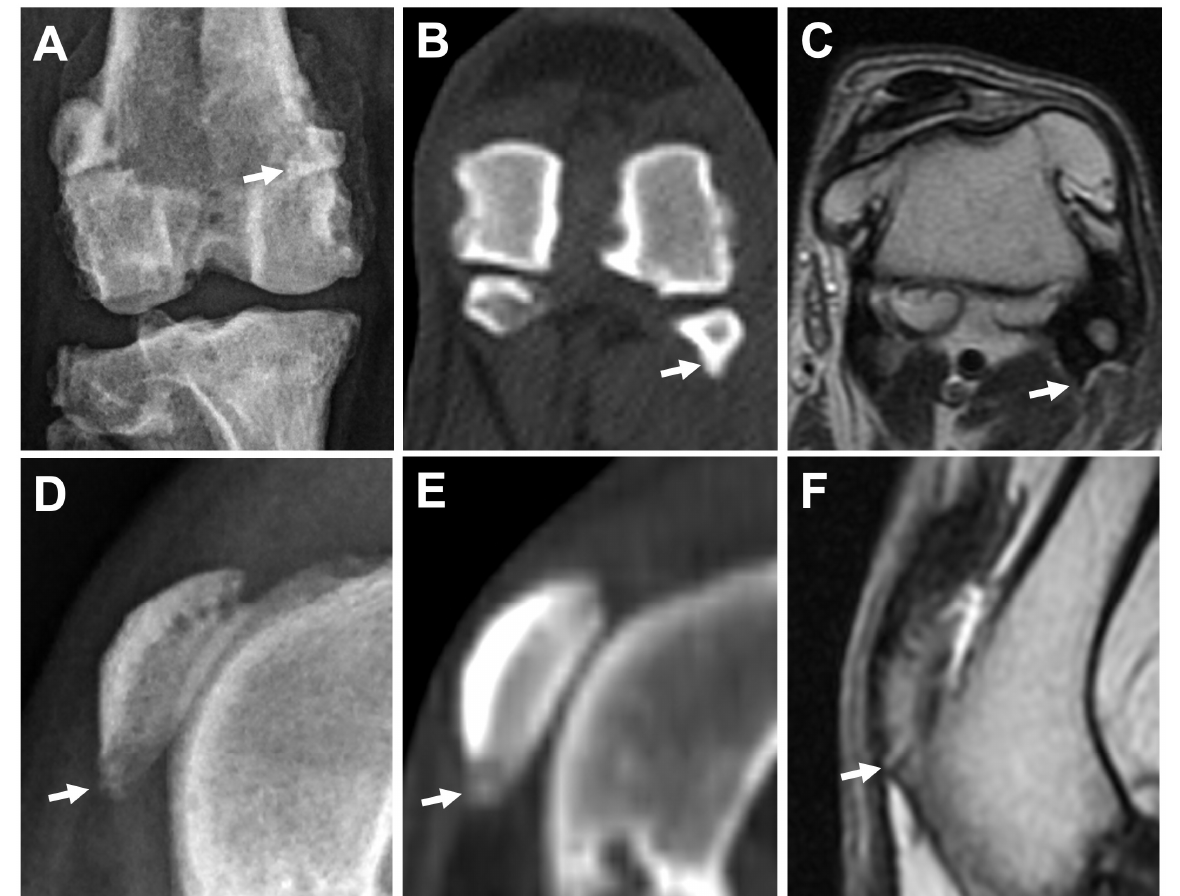
Figure 6. Comparison of osteophytes/enthesophytes at fabella using different imaging modalities in the same leg. Caudocranial view of DR ( A ), bone window of CT (transverse plane) ( B ), and T2W MRI (transverse plane) ( C ) images. Enthesophytes/osteophytes at lateral fabella (arrows) are superimposed with the distal femur on DR image ( A ), but can be easily identified on CT image ( B ), while exhibiting similar hypointense signal with the attached femoropatellar ligament on MRI image ( C ). Mediolateral view of DR ( D ), and sagittal plane of CT ( E ) and MRI ( F ) images in the same leg. A hyperintense projection of the distal patella (arrow), which can be seen on MRI ( F ) with a score = 2, is graded score = 1 and score = 0 on DR ( D ) and CT ( E ) images, respectively. Table 3. Comparison of the osteophytes/enthesophytes lesion on DR, CT, and MRI images at differ- ent anatomic subregions.